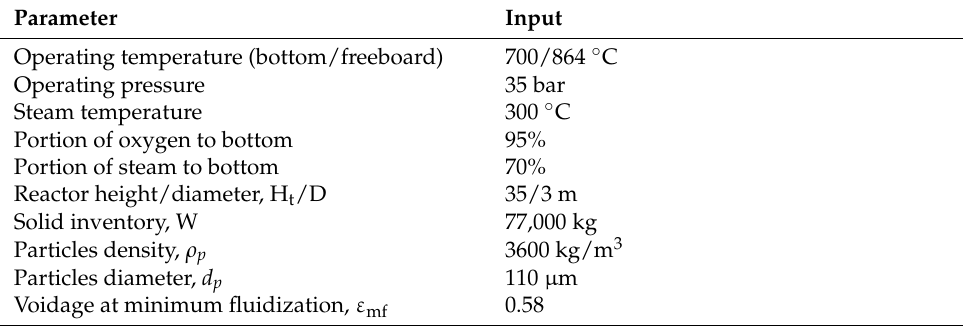
Table 3. HTW gasifier unit process